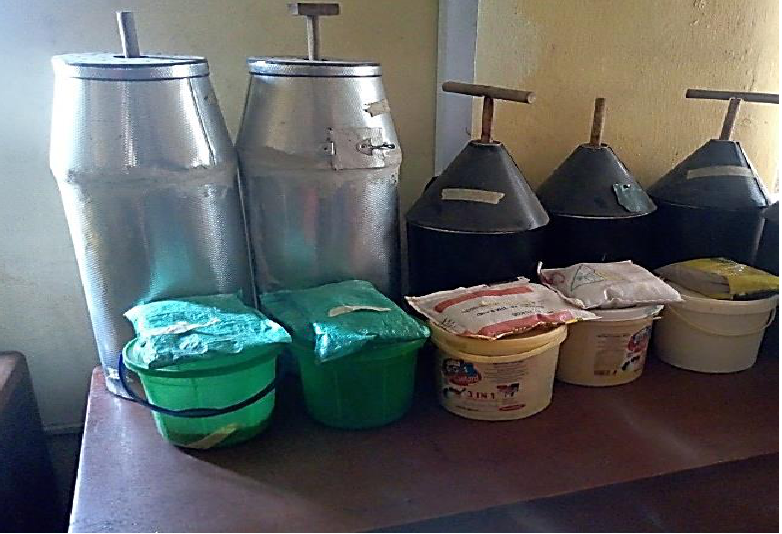
Figure 2. The different storage strategies for household preservation of breadfruit seeds.